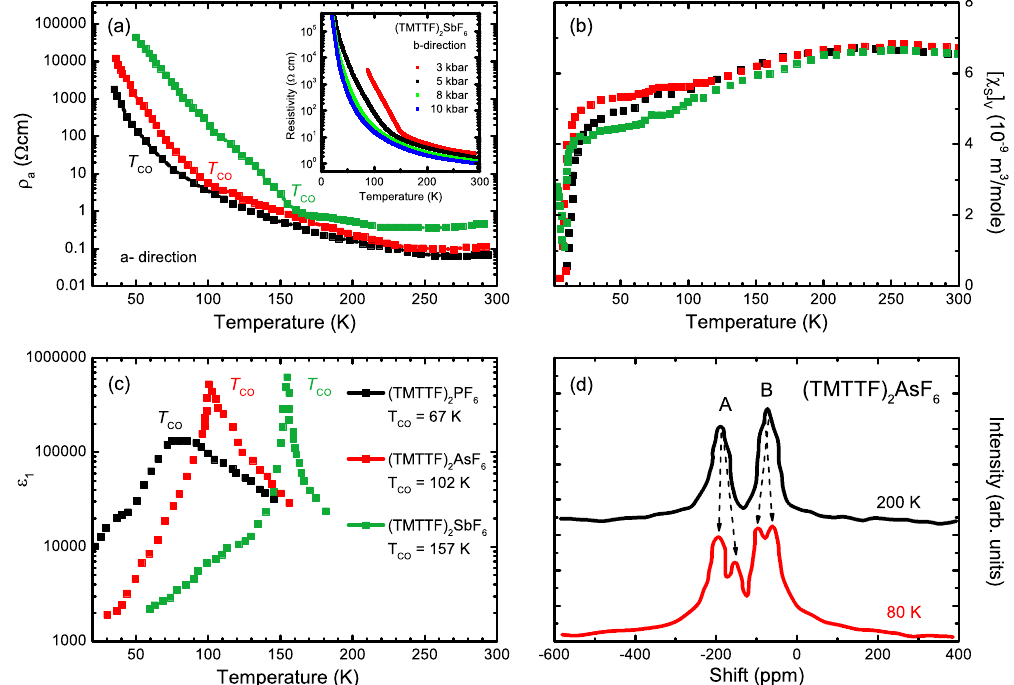
Figure 1. Experimental characterization of (TMTTF) 2 X , X = PF 6 (black), AsF 6 (red), and SbF 6 (green) single crystals. ( a ) Temperature-dependence of the resistivity along the a -direction [10]. The labels mark the charge-order transition temperature T CO = 67, 102, and 157 K, respectively. The inset demonstrates the effect of hydrostatic pressure on the transition by displaying the temperature-dependent dc resistivity of (TMTTF) 2 SbF 6 measured along the b -direction. T CO is seen as a kink in ρ ( T ) that shifts to low temperatures as pressure increases; ( b ) Temperature-dependence of the spin susceptibility at constant volume [ χ S ] v . (TMTTF) 2 PF 6 and (TMTTF) 2 AsF 6 undergo a spin-Peierls transition at T SP = 19 K and 13 K, respectively. (TMTTF) 2 SbF 6 exhibits an antiferromagnetic state below 8 K causing an increase of [ χ S ] v . Above the transition [ χ s ] v can be described by a model of a 1/2 antiferromagnetic Heisenberg chain [16,39]; ( c ) The real part of the dielectric constant (cid:101) 1 maesured at f = 100 kHz as a function of temperature T reveals a Curie-law behavior [40]; ( d ) 13 C-NMR spectra of (TMTTF) 2 AsF 6 at 200 K and 80 K. Above T CO = 102 K two distinct features A and B can be identified due to the two molecules per unit cell. They split into a total of four peaks, as depicted by the arrows [41], giving evidence for charge